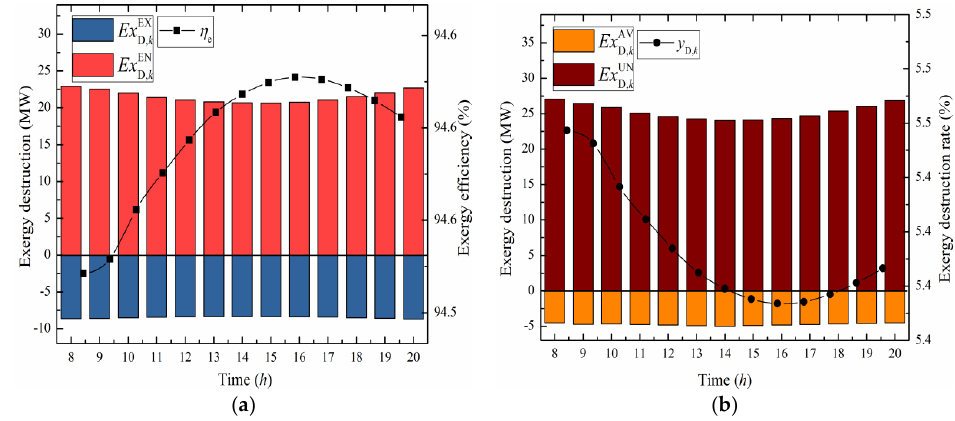
Figure 6. The exergy destruction, exergy efficiency and exergy destruction rate of gas turbine variation with time. ( a ) The endogenous/exogenous exergy destruction and exergy efficiency